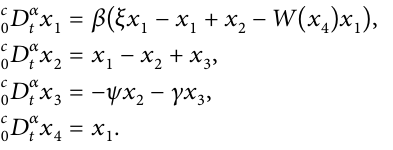
, ; (b) , ; (c) , ; (d) , 𝑥 1 (𝑡) 𝑥 2 (𝑡) 𝑥 2 (𝑡) 𝑥 3 (𝑡) 𝑥 2 (𝑡) 𝑥 4 (𝑡) 𝑥 1 (𝑡) 𝑥 4 (𝑡)